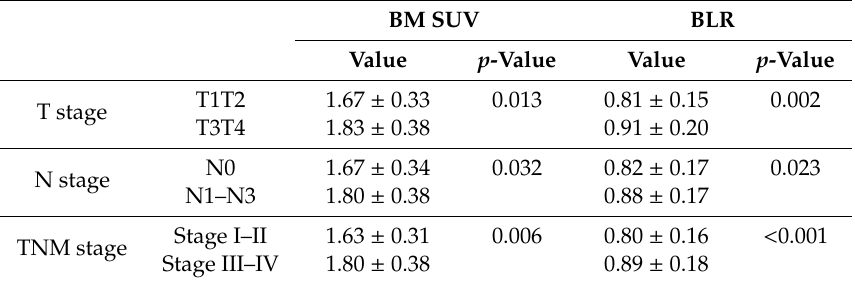
Figure 1. Maximum intensity projection ( a ) and sagittal ( b ) FDG PET images and fused transaxial FDG PET / CT images ( c , d ) of a 64-year-old man with nasopharyngeal cancer. A 3 cm-sized mass in the left nasopharynx showed intensely increased FDG uptake (arrow) (maximum SUV 9.53, metabolic tumor volume 28.83 cm 3 , and total lesion glycolysis 132.62 g) with ipsilateral neck lymph node metastases (arrowhead). Serum CRP level, NLR, and PLR of the patients were 3.02 mg / dL, 2.53, and 212.38, respectively. On FDG PET / CT, only a mild degree of FDG uptake was shown in the bone marrow (BM SUV of 1.13 and BLR of 0.64). The patient was clinically diagnosed with T3N1, stage III, and underwent concurrent chemoradiotherapy. The patient has not experienced cancer progression during 48.8 months of follow-up. Table 2. Correlation of PET / CT parameters of BM with T stage, N stage, and TNM stage.